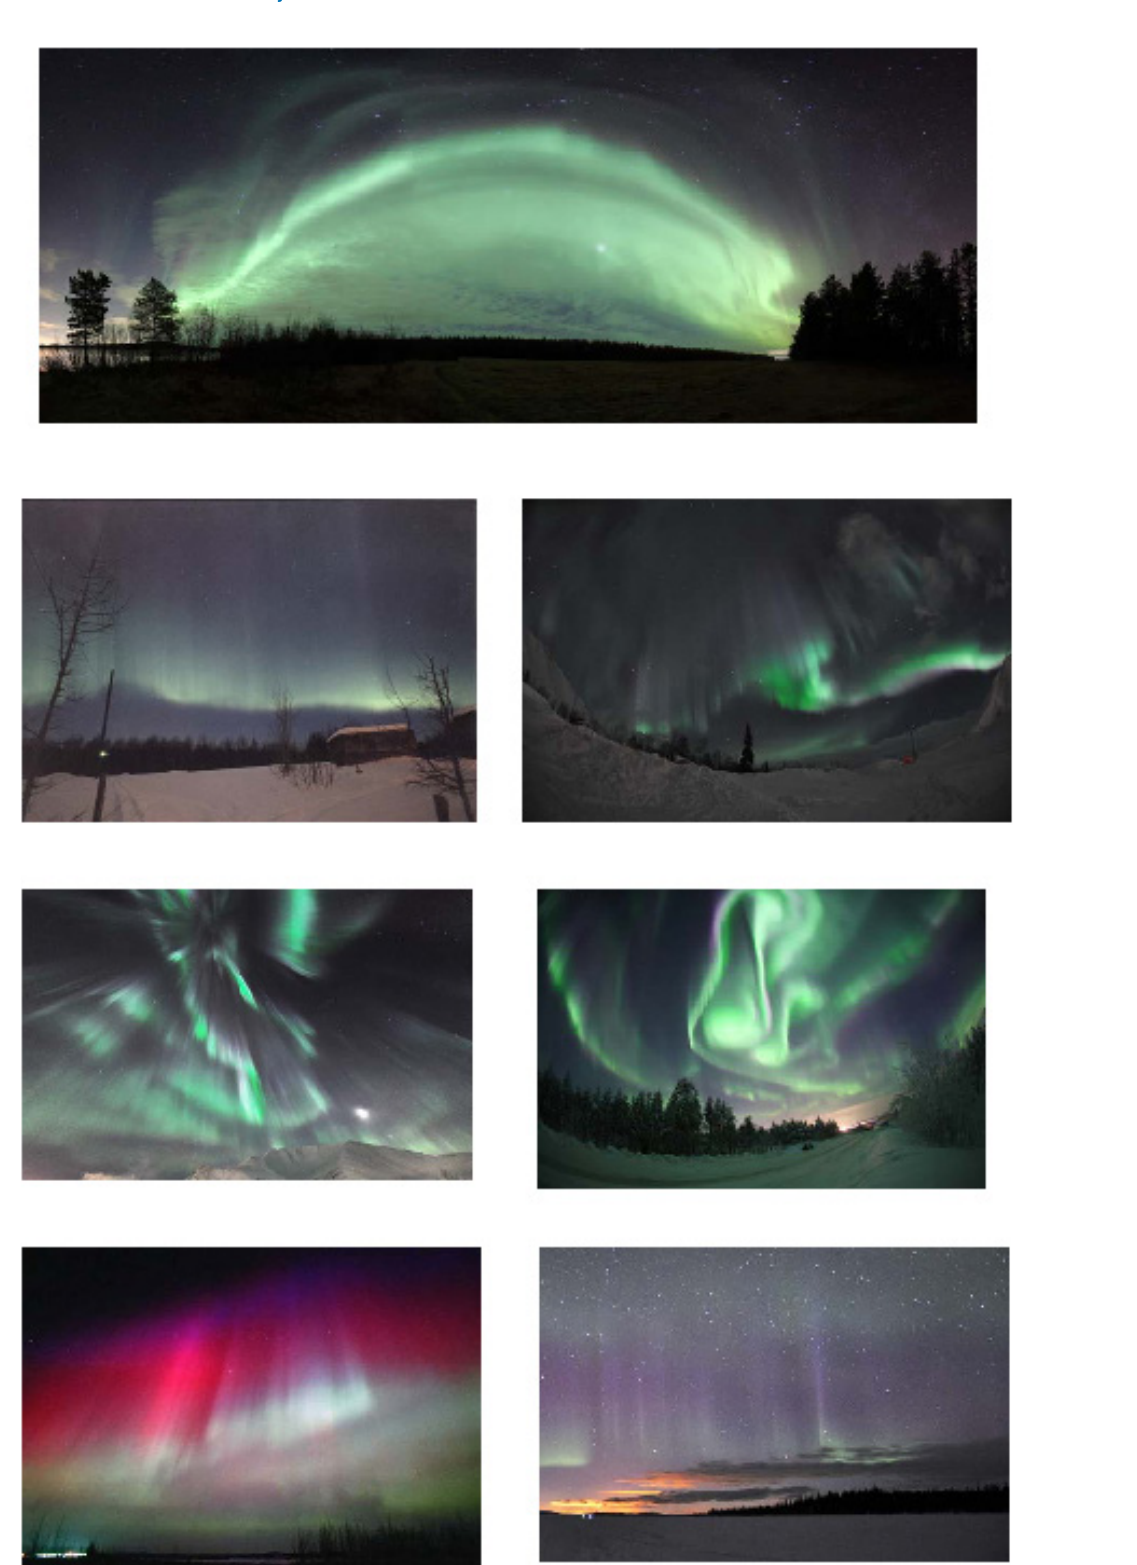
Plates I–VII. Photos of various auroral types, taken at the Kola Peninsula by S. A. Chernouss and V. Yu. Zhiganov (Apatity, Russia). From top to bottom: (I) Homogeneous auroral arc, (II) rayed arc, (III) long auroral rays, (IV) corona – emissions along the magnetic field lines, (V) drapery – ribbon-like auroral forms, (VI) simultaneous green and red auroral emissions at different heights, and (VII) sunlit